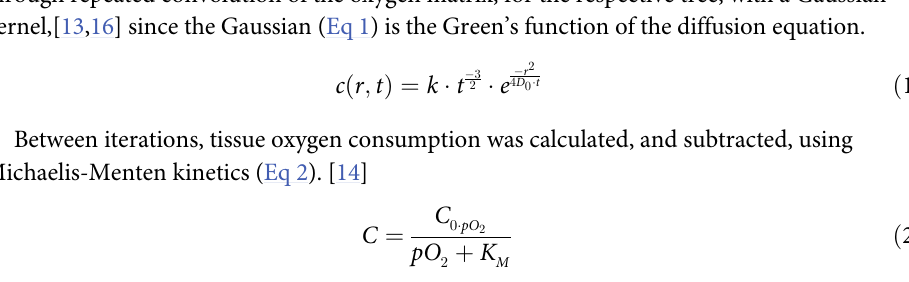
Fig 2. Generation of vesseltrees. The process of stochastic generation of vessel trees. New directions and distanceswere samplediterativelyuntil all branches had reachedthe predetermined vessel generation